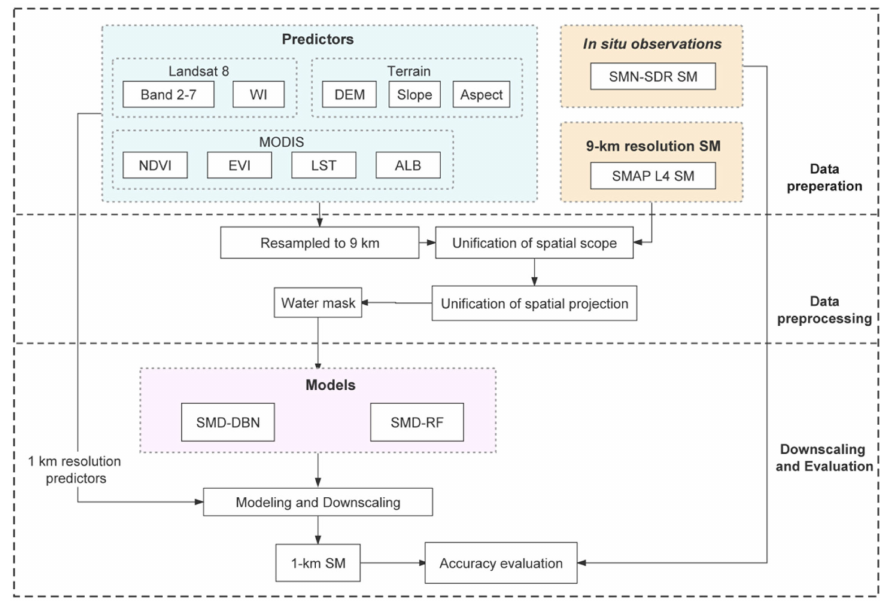
Figure 2. Flowchart of the study. Table 2. Correlation of